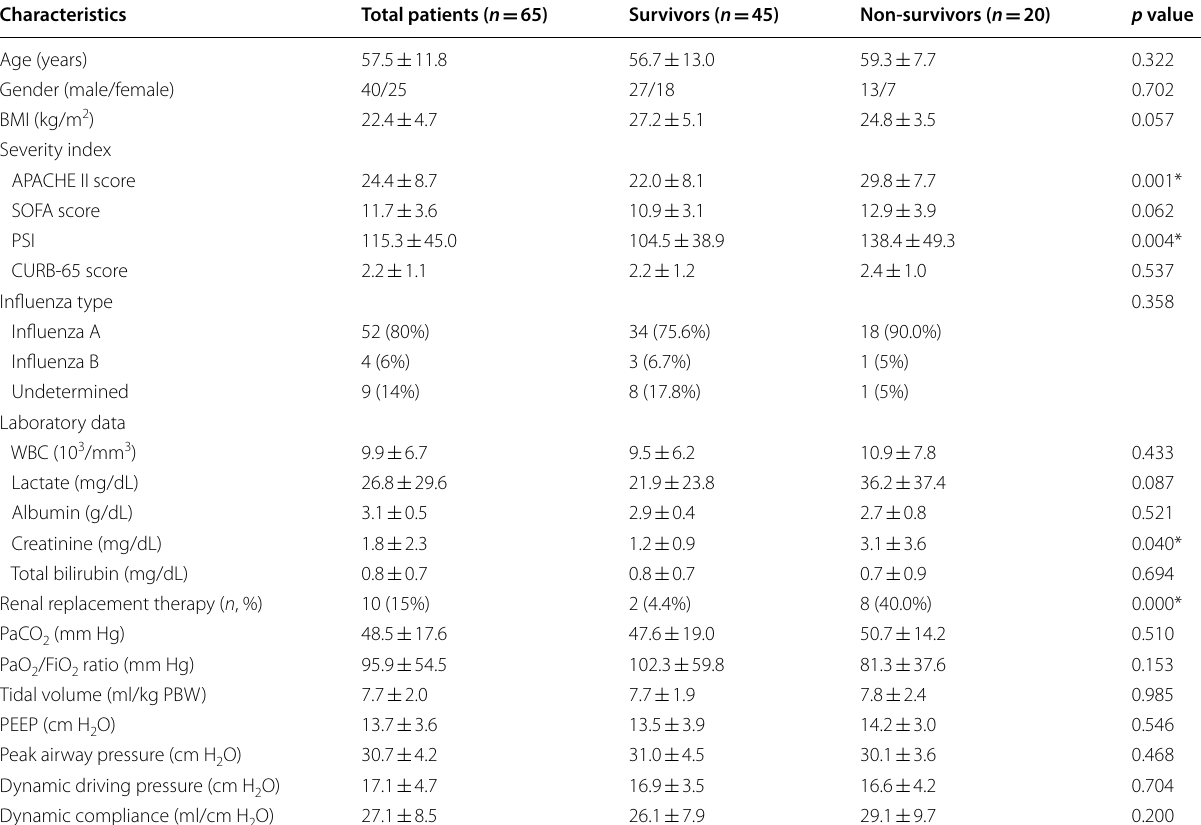
Table 1 Characteristics of 60-day survivors and non-survivors of influenza pneumonia-related ARDS before prone